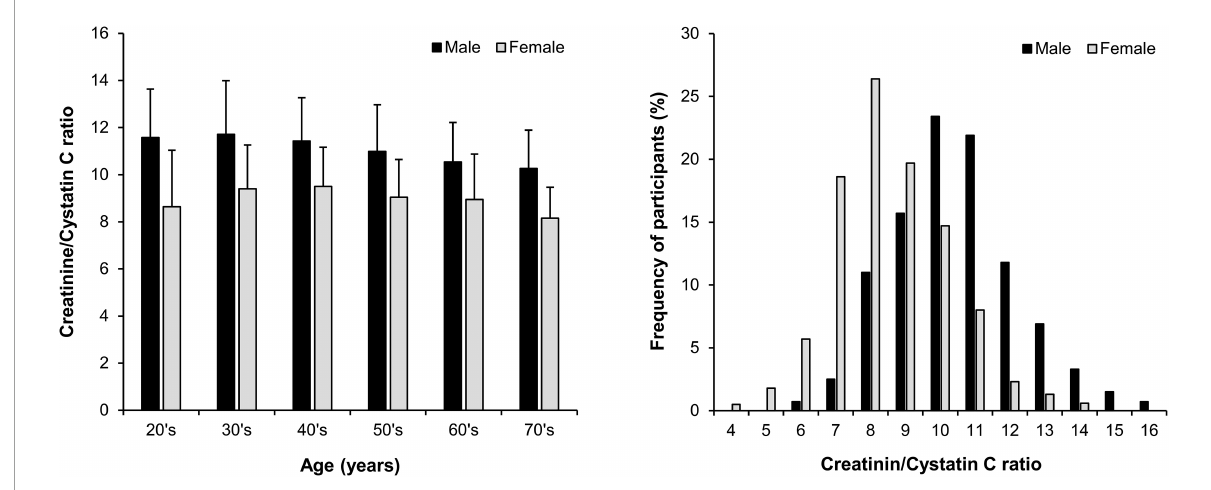
FIGURE1 Distribution of the serum creatinine/cystatin C ratio (mean ± SD) by age and sex in 1,966 participants with non-dialysis chronic kidney disease.